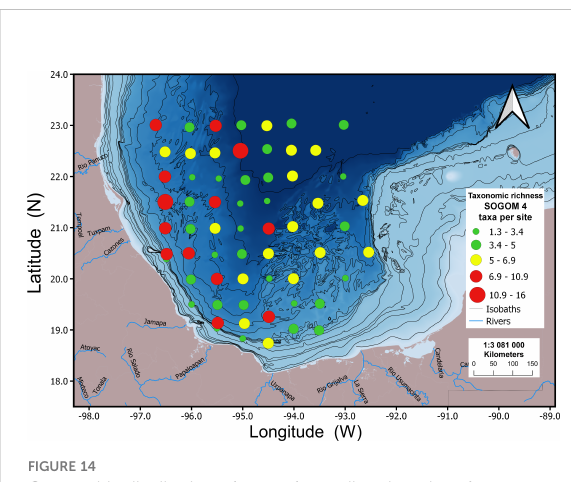
FIGURE 14 Geographic distribution of macrofauna diversity values for SOGOM